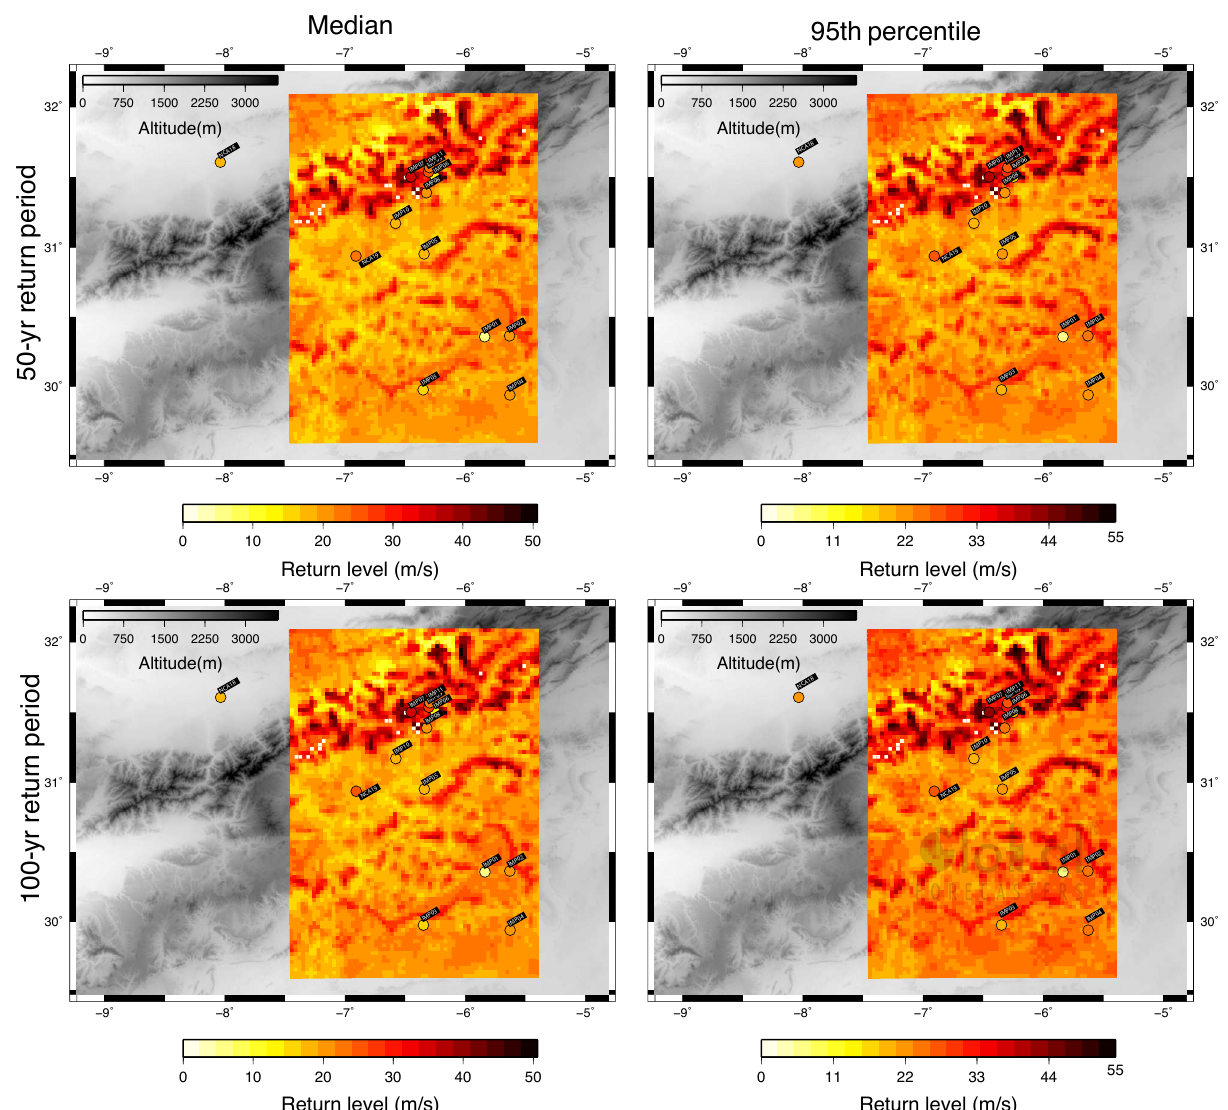
Figure 12. Maps of simulated wind return levels for a 50-year ( top ) and 100-year ( bottom ) return periods obtained from the regional model unmasked simulation for a region within the D3 domain (sub-domain D4). The median ( left ) and the 95th percentiles ( right ) from the mixed PDF at every grid-point were represented. Return levels calculated from observations are also represented (circles) for comparison. Note that only those observational sites with remaining successful experiments from the sensitivity analysis in Section 4.1 are included in these